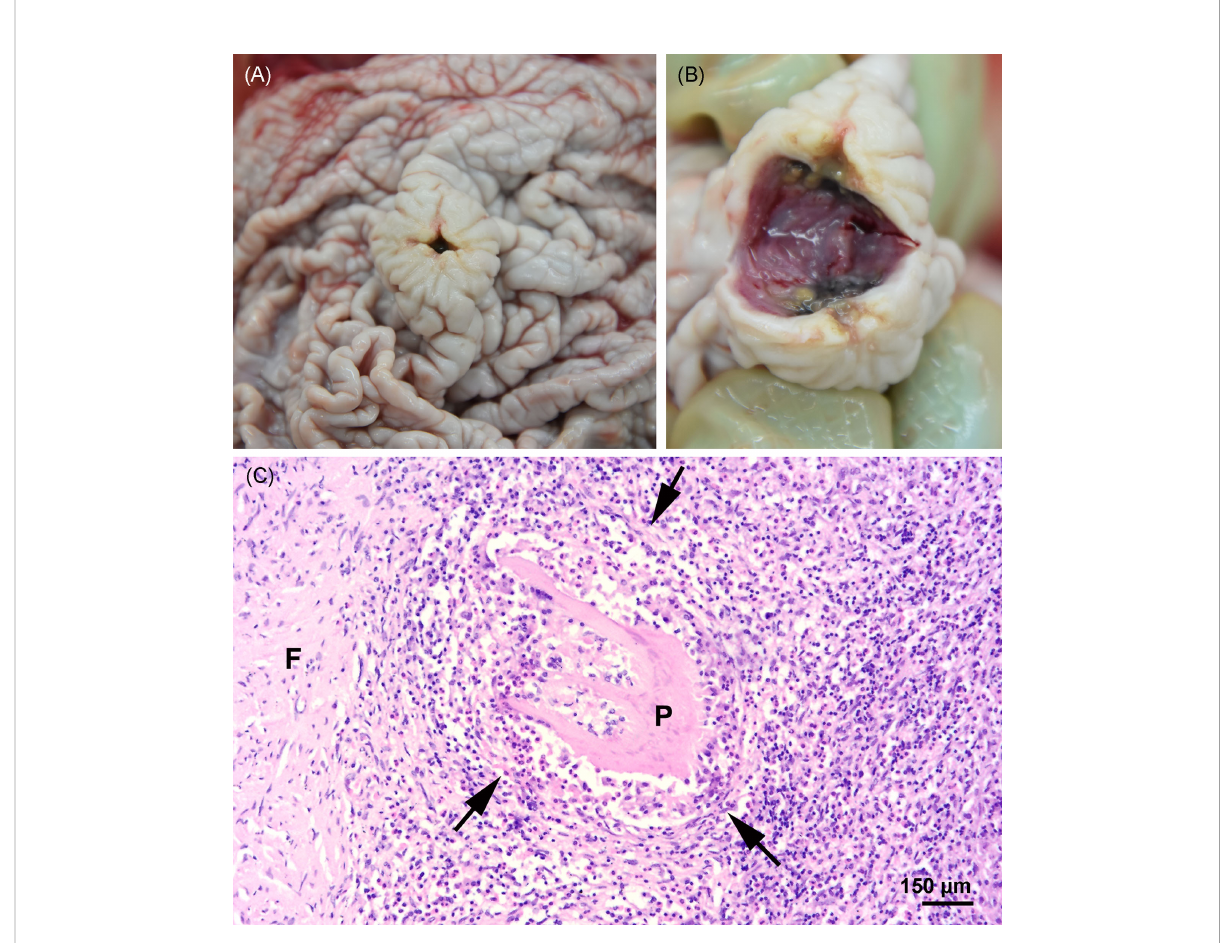
FIGURE 5 (A, B) Nodule in the stomach at necropsy. (C) Focal severe granulomatous, mural gastritis (arrows), intralesional parasitic structure (P), and perifocal fi brosis (F) in the stomach; hematoxylin and eosin stain.